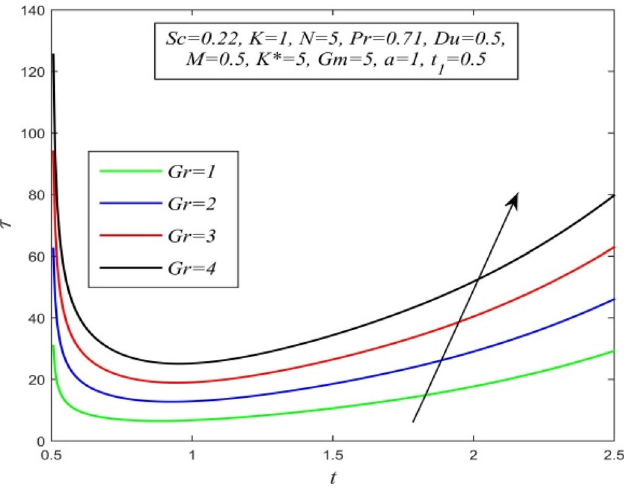
Figure 29. τ versus t for different Gr and Sc = 0.22, K = 1, N = 5, Pr = 0.71, Du = 0.5, M = 0.5, K* = 5, Gm = 5, a = 1, t 1 = 0.5.